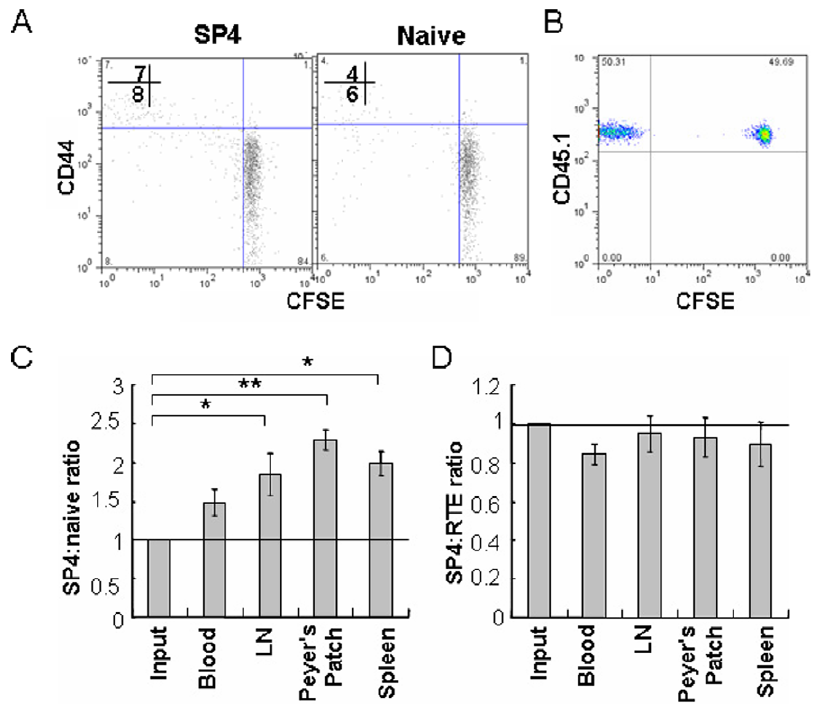
Figure 2. Comparison of the survival of pre-RTEs (SP4 in adult animals) and naı¨ve T cells in mice. (A) Purified SP4 thymocytes, and CD4 + naı¨ve T cells from lymph nodes of C57BL/6 mice were labeled with CFSE and adoptively transferred into unirradiated adult C57BL/6 mice. Donor T cells from lymph nodes (LN) of the hosts were analyzed for CD44 expression and CFSE dilution (proliferation) 7 days later. The numbers in the plot display the percentage of CD44 hi (upper) and CD44 lo (lower) cells that diluted CFSE. (B) Unlabeled SP4 thymocytes (pre-RTEs) and CFSE-labeled CD4 + naı¨ve T cells of CD45.1 congenic mice were mixed at 1:1 ratio and were adoptively transferred into CD45.2 C57BL/6 mice. Seven days later, the mice were sacrificed and cells were harvested from peripheral blood, lymph nodes, peyer’s patch, and spleen. Donor cells collected from host lymph nodes were shown as CD45.1 + CFSE + (naı¨ve T) and CD45.1 + CFSE - (SP4). (C) The ratio of SP4 and naı¨ve T cells (gated as (B)) after seven days of adoptive transfer was calculated. (D) Unlabeled SP4 thymocytes and CFSE-labeled GFP + CD4 + CD8 - lymph node cells (RTEs) from CD45.2 mice were mixed at 1:1 ratio and were transferred into CD45.1 mice. The donor cells were gated at CD45.2 + CFSE + (RTEs) and CD45.2 + CFSE - (SP4) and the ratio was analyzed 7 days later. The experiments were repeated twice and similar results were obtained. Error bars represent SEM. *P , 0.05, **P , 0.01, using an unpaired Student’s t test. N=3-4 mice per group.